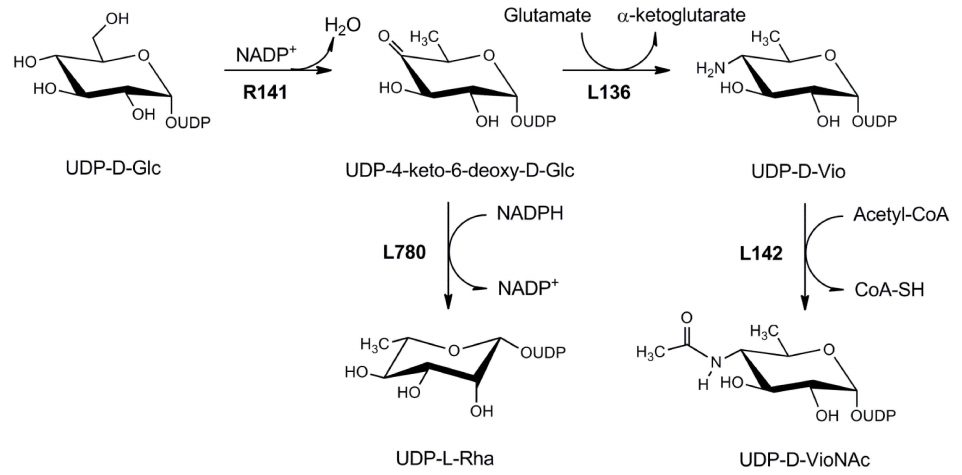
Figure 3. Metabolism of UDP- L -rhamnose and UDP- D -viosamine in Mimivirus. R141 is a UDP- D -glucose 4,6-dehydratase. The resulting product, UDP-4-keto-6-deoxy-glucose is the substrate for both L780, a NADPH-depdendent 3,5-epimerase/4-reductase forming UDP- L -rhamnose, and for L136, a PLP-dependent sugar aminotransferase leading to UDP- D -viosamine. The 4-amino group of viosamine is further acetylated by